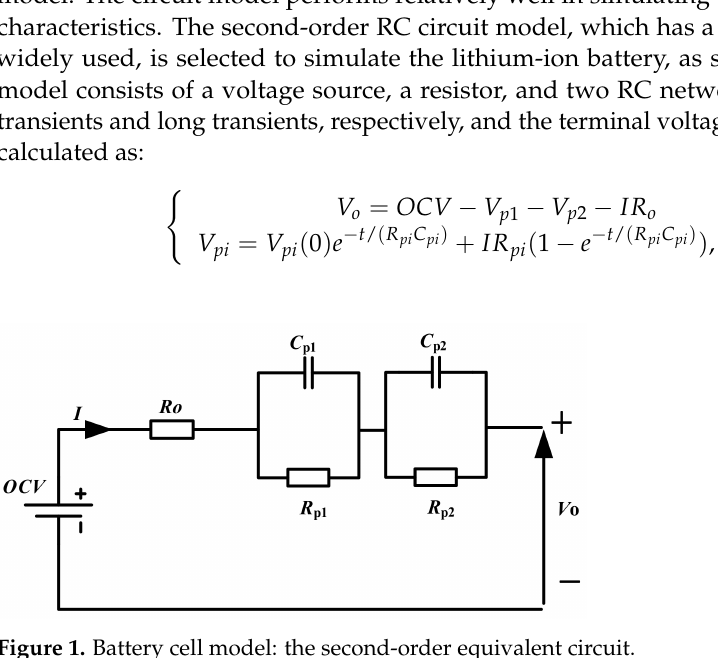
Figure 1. Battery cell model: the second-order equivalent